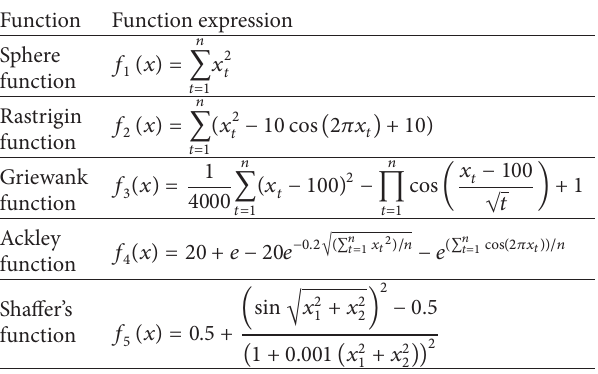
Table 1: Functions used to test the effects of ADE.